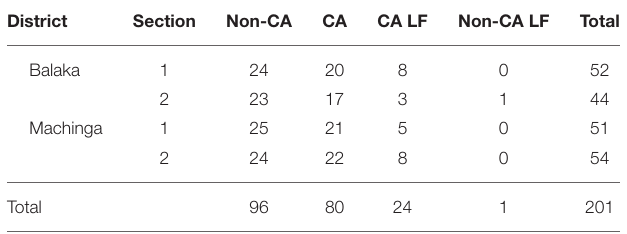
TABLE 1 | Distribution of non-CA and CA farmers participating in the household survey.